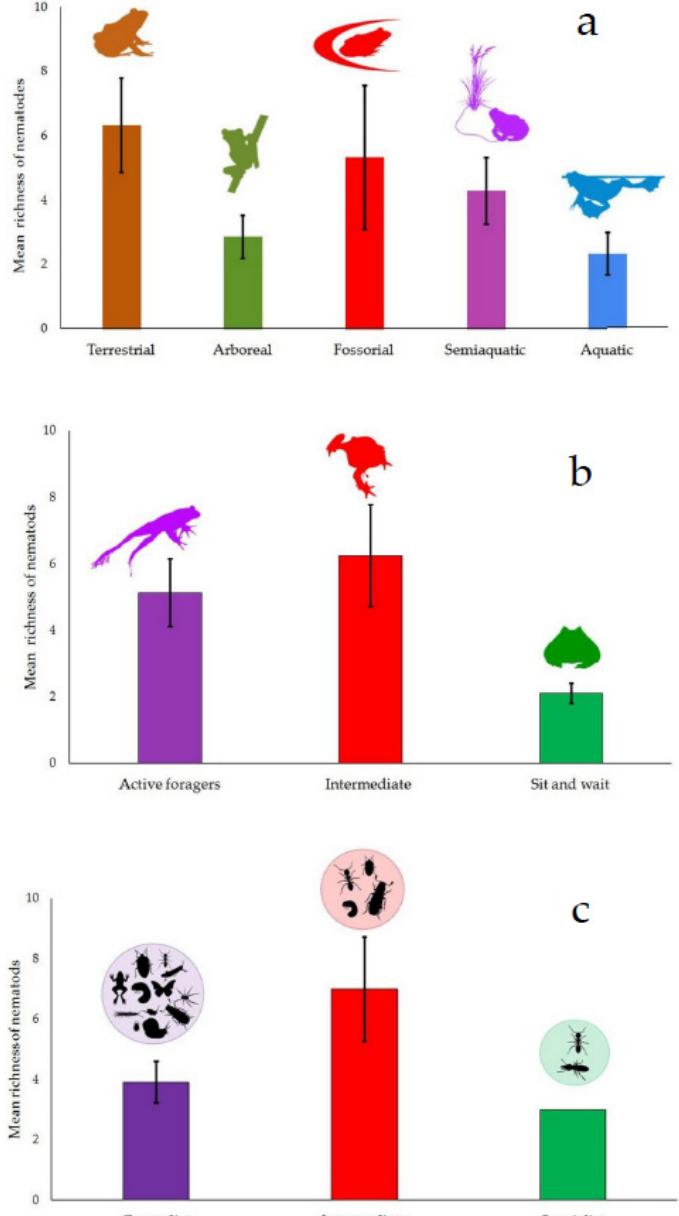
Figure 5. Comparison of host habitat preferences ( a ), foraging mode ( b ) and diet type ( c ) with the mean species richness ( ± 1 SE) of nematode parasites.